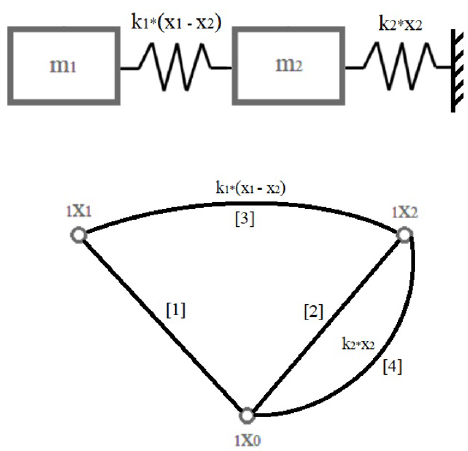
Figure 5. A graph representation of displacements and the base vertex.